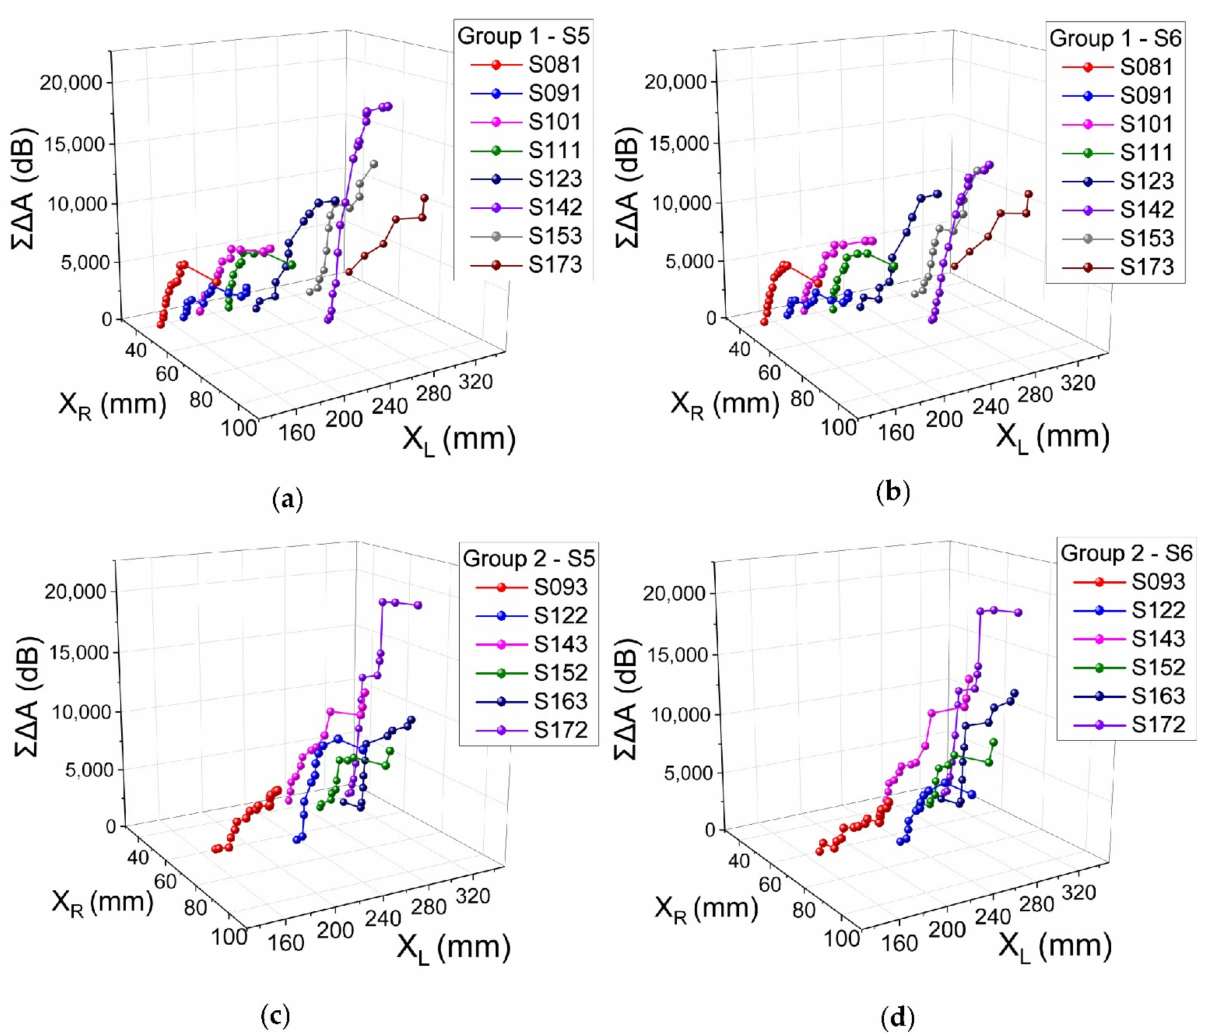
Figure 8. Three-dimensional graphs: x-axis—radial position X R (mm); y-axis—longitudinal position X L (mm); z-axis— cumulative sum of the amplitude, i.e., Σ∆ A (dB). ( a ) Group 1, S5; ( b ) Group 1, S6; ( c ) Group 2, S5; and ( d ) Group 2, S6.